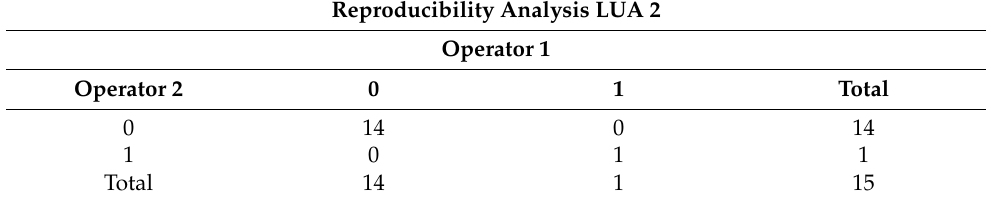
Table 8. Number of lung ultrasound areas interested by lung ultrasound alteration 2 (LUA 2) found by operator 1 and